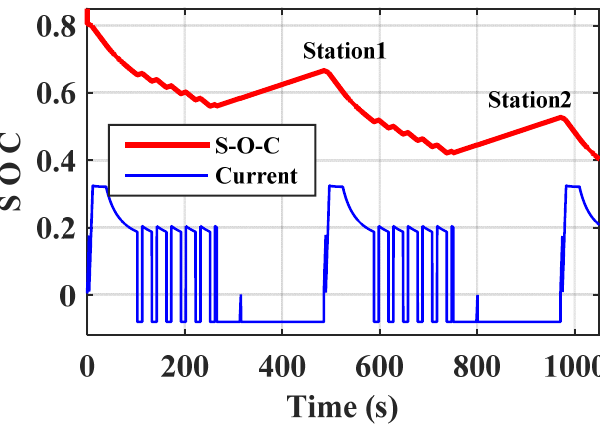
Figure 14. Battery’s state of charge with actual load profile scaled (sized for maximum load).